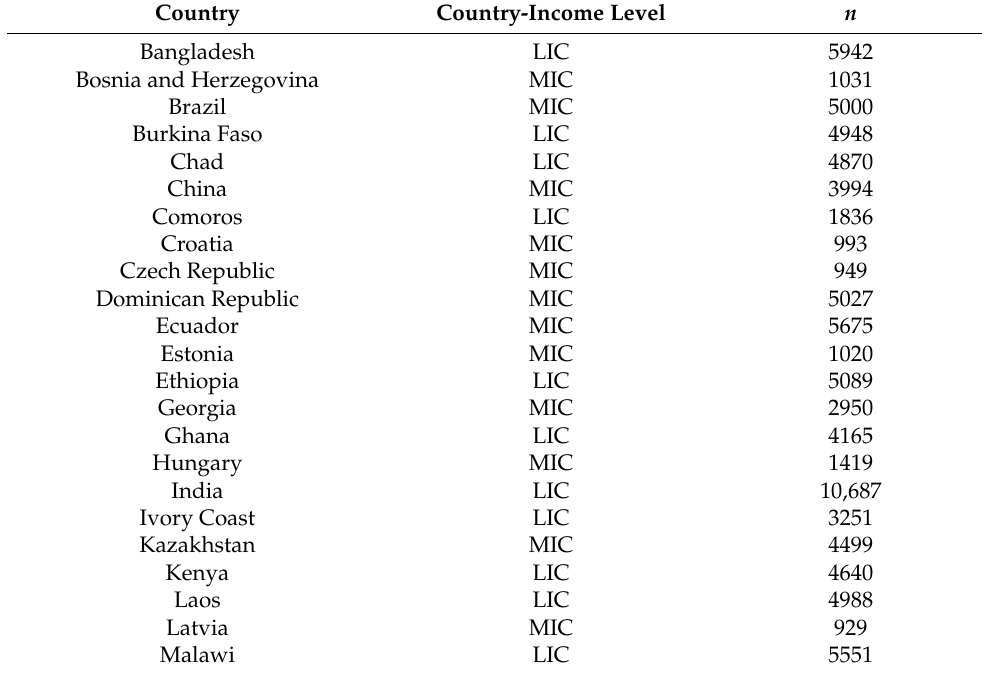
Table A1. Countries included in the